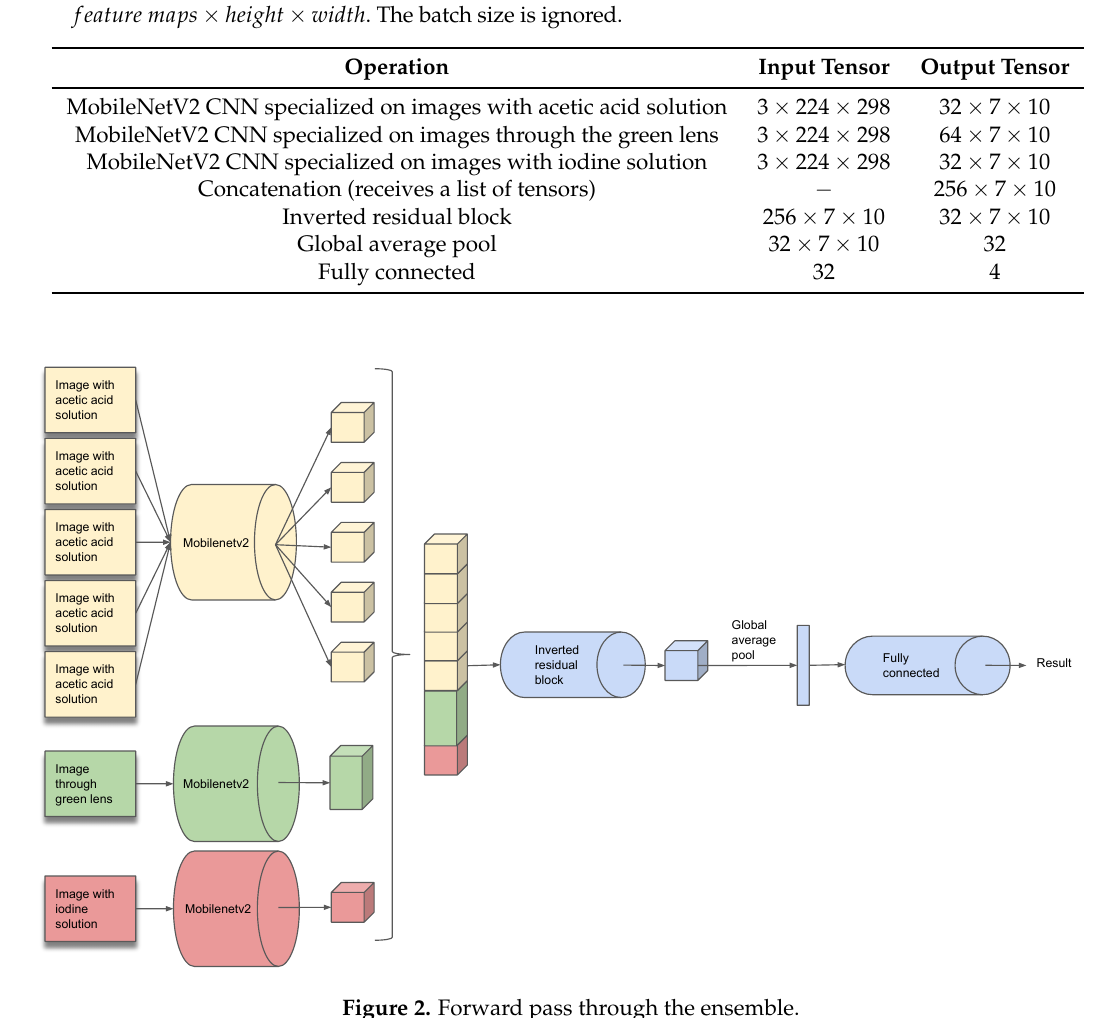
Figure 2. Forward pass through the